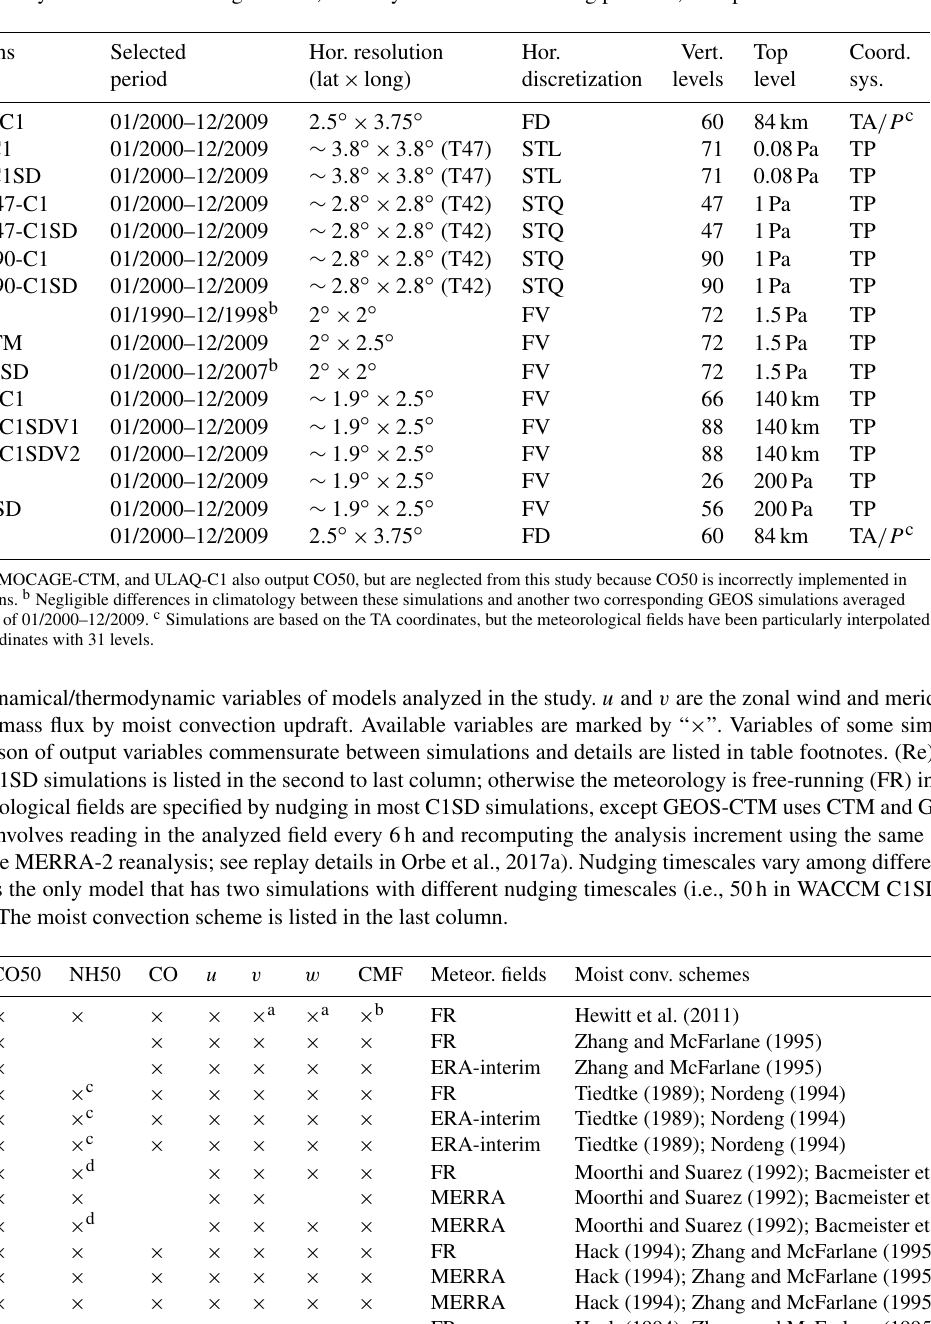
Table 1. Simulations analyzed in this study a and their corresponding selected period and horizontal and vertical configurations. Names of simulations follow those in Orbe et al. (2018). FD is finite difference; FV is finite volume; STL is spectral transform linear; STQ is spectral transform quadratic; TA is hybrid terrain-following altitude; TP is hybrid terrain-following pressure; P is pressure.